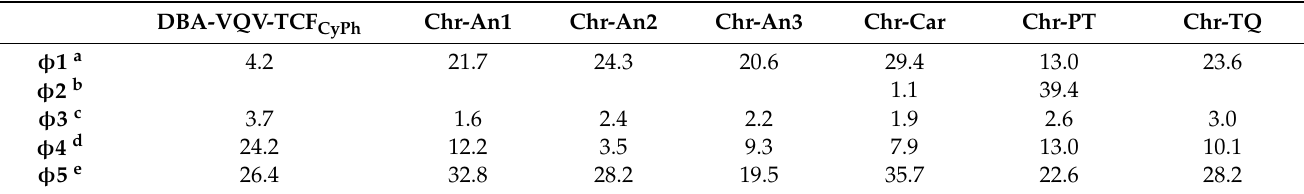
Table 4. Dihedral angles characterizing the geometry of the chromophores ( tct